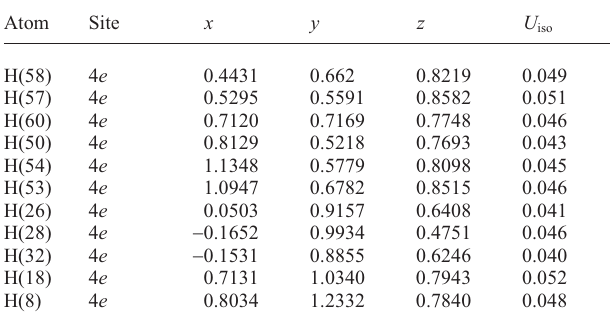
Table 2. Atomic coordinates and displacement parameters (in Å 2 )